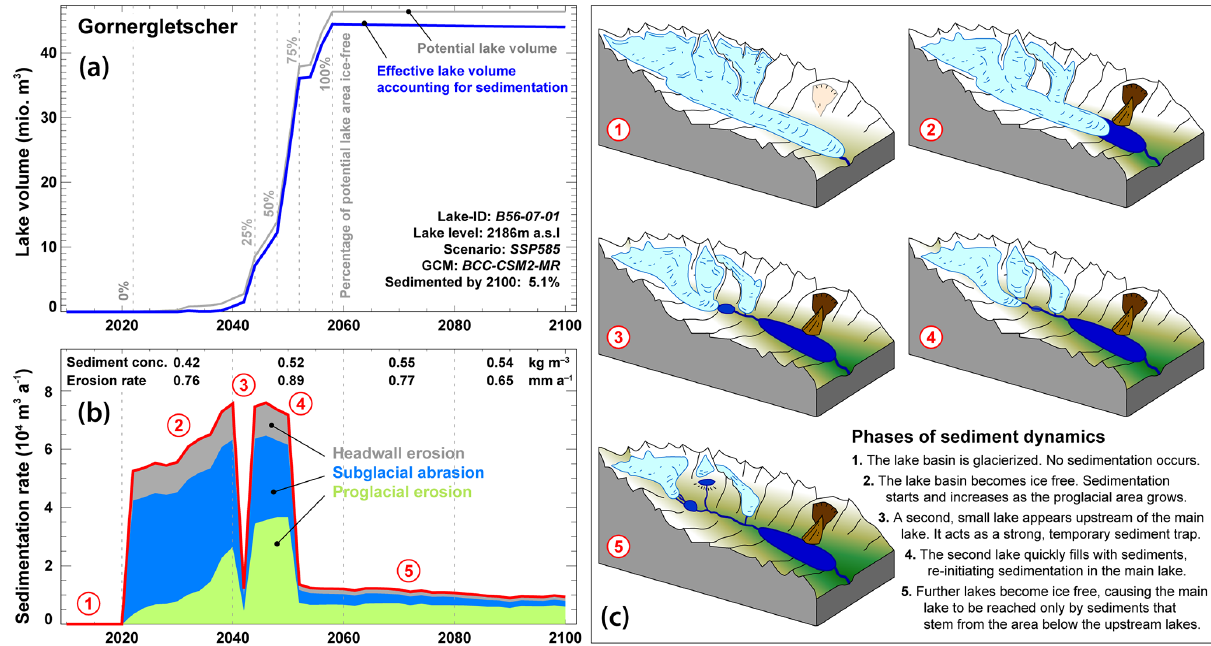
Figure 5. Temporal dynamics of lake volume growth and modelled sedimentation for the example of Gornergletscher (SGI-ID B56-07; see Fig. 1 for location), harbouring the third-largest new glacier lake in Switzerland (see Table 1). Results refer to a selected GCM amid the climate scenario SSP585. (a) Lake volume evolution when neglecting (grey) or accounting for (blue) sedimentation. Percentages of exposed potential maximum lake area over time are shown (grey vertical numbers). (b) Modelled lake sedimentation rate, including the partitioning of the three considered sediment sources (see Sect. 3.2). The strong temporal variations are due to the appearance and refilling of smaller glacier lakes located above the considered lake. The red numbers represent distinct phases of sediment dynamics as illustrated in panel c . Values in the upper part of the panel show (i) sediment concentrations in the runoff from the catchment area contributing to the lake at a given point in time and (ii) modelled catchment erosion rates. Both quantities are evaluated over 20-year time steps, and the latter quantity is obtained by assuming an average density for eroded materials of 2800kgm − 3 and by dividing the catchment-wide sediment yield (now expressed in m 3 yr − 1 ) by the catchment area. (c) Illustration of the individual phases of sediment dynamics given in panel (b) . Further explanations are given in the bottom-right corner of (c) . The illustration is adapted from Otto